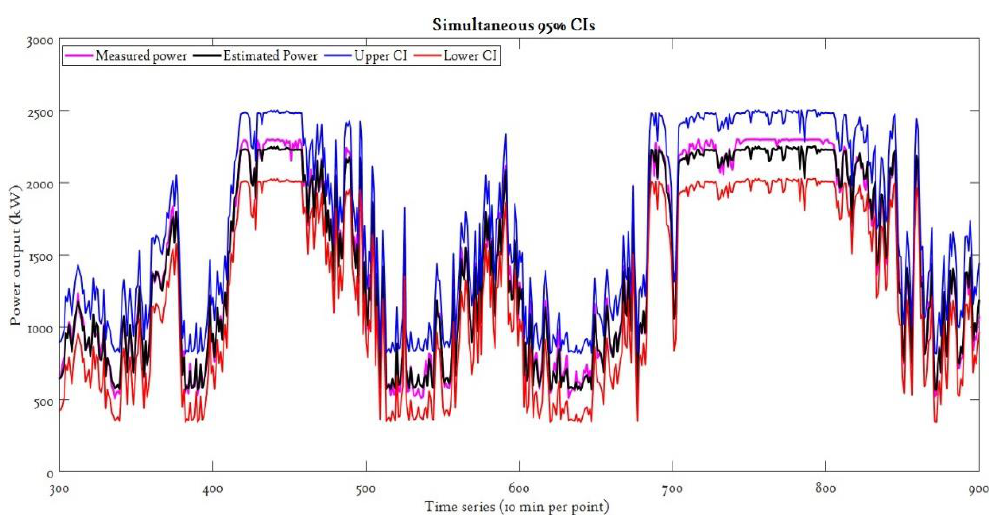
Figure 10. Analysis of simultaneous CIs for estimated power values in time-series.